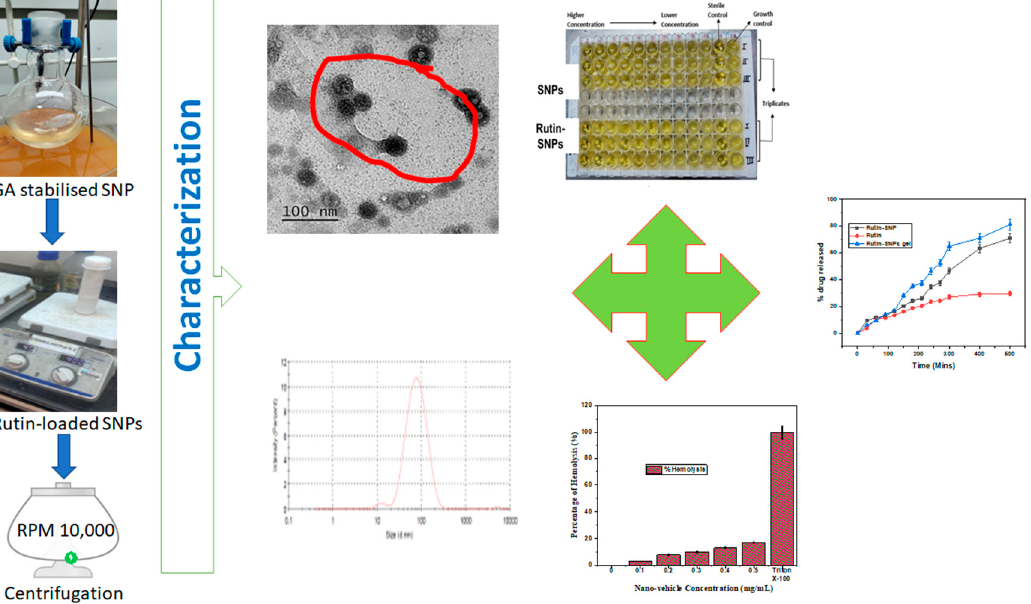
Figure 1. Schematic representation of workflow.